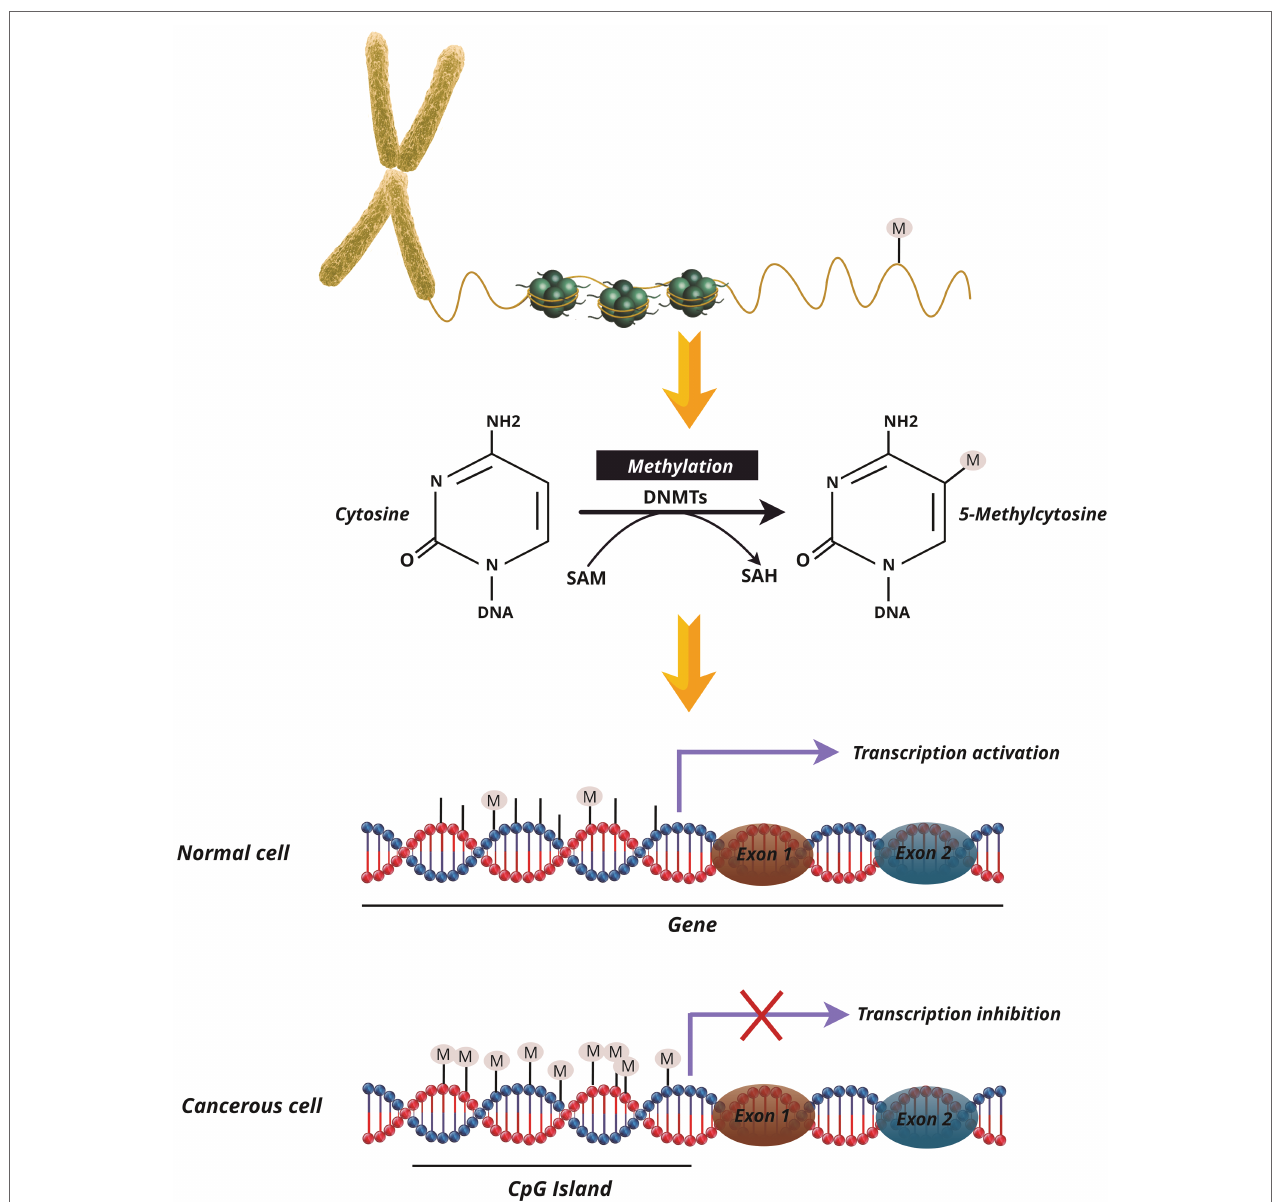
FIGURE 3 | Methylation and its function in the genome of healthy and cancer cells. Cytosine methylation in cells is regulated by DNA methyltransferases (DNMTs). By switching methyl groups from S-adenosylmethionine (SAM) to S-adenosylhomocysteine (SAH), methylation is done in the CPG Islands in the promoter of genes. Normal cell promoters are immune to methylation, resulting in gene transcription. However, in mutant and cancerous cells in the promoter regions of the genes, hypermethylation is done and inhibits the transcription of such genes, such as tumor suppressor genes, as a result of gene